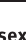
Case Age Type of lymphedema Stage Time after